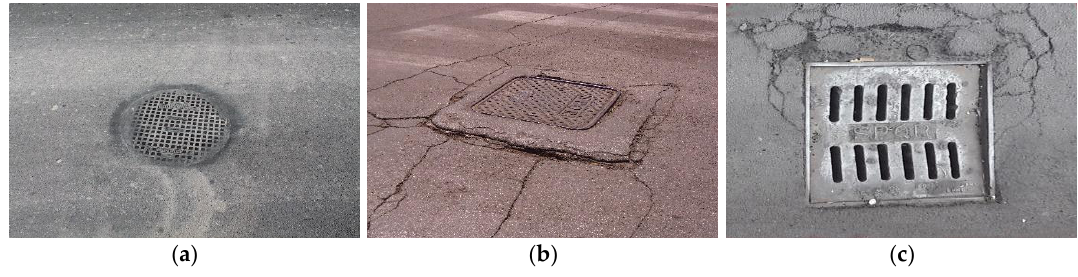
Figure A5. Manholes. ( a ) Low Severity; ( b ) Medium Severity; and ( c ) High Severity.